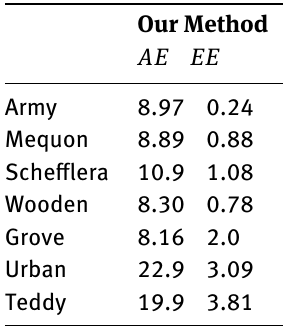
Figure 5: The top row shows the first frame of the input sequences used to our study. The middle row shows the color coded ground truth flow of each image. The bottom row shows the estimated optic flow of our algorithm. In the left-most column we visualize the color coded ground truth flow that indicate speed and direction.